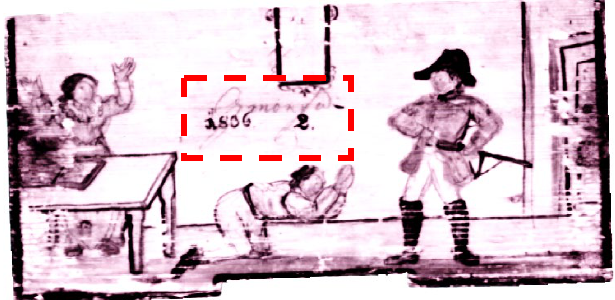
Figure 7. The hidden underdrawings in the inner layer of the studied beehive panel painting detected using the FX17 and SWIR hyperspectral cameras (NIR wavelength: 1500 nm).